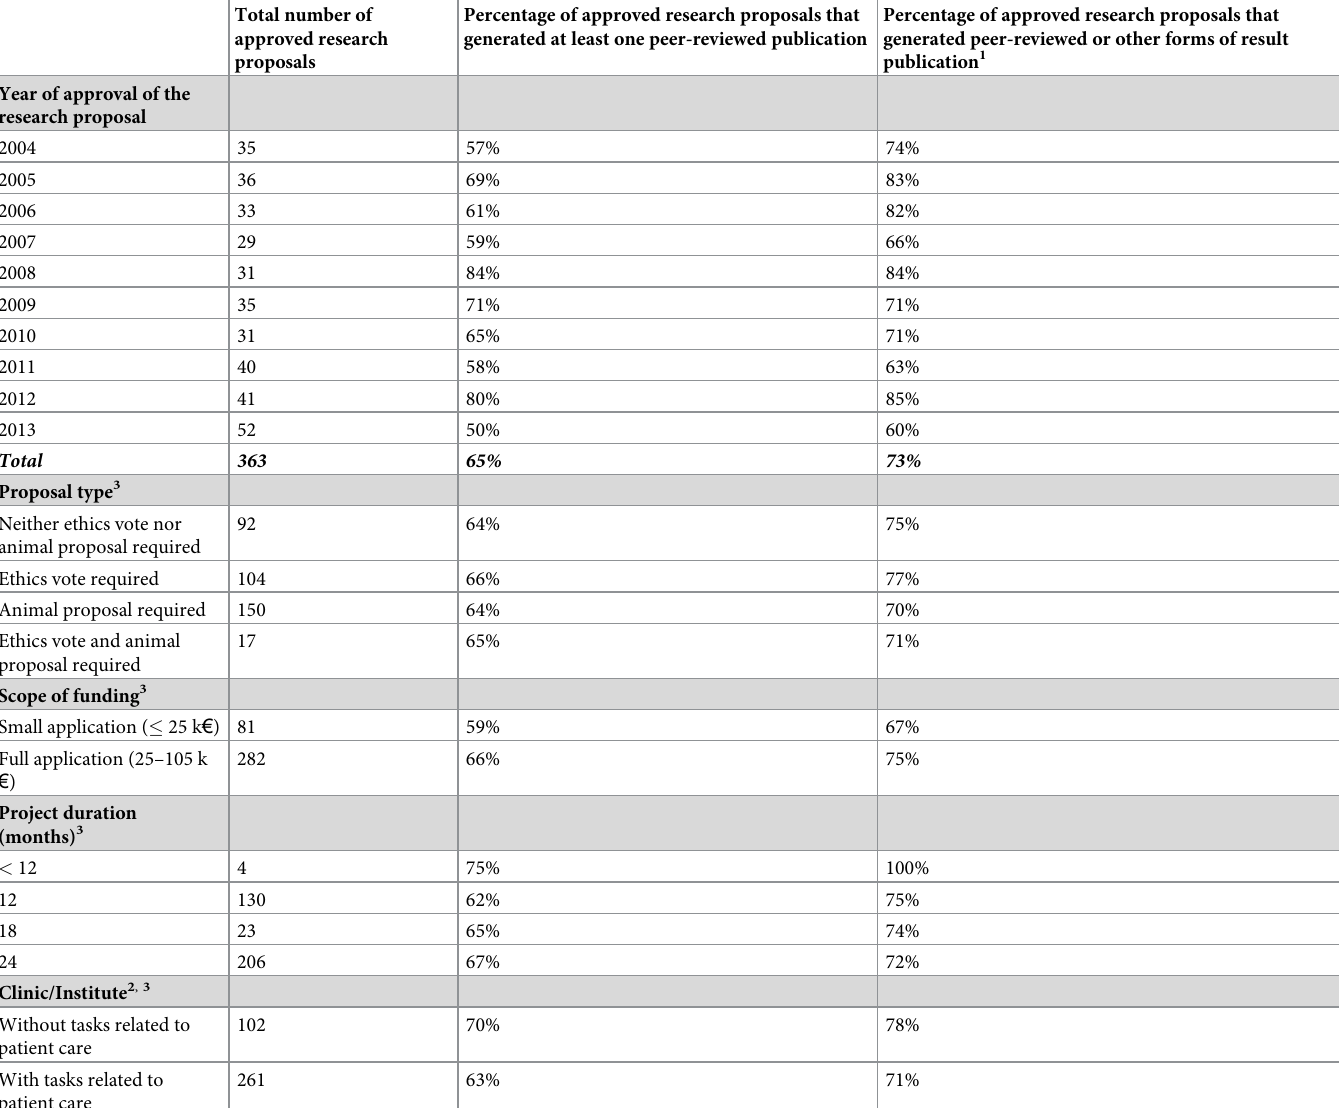
Table 1. Publication